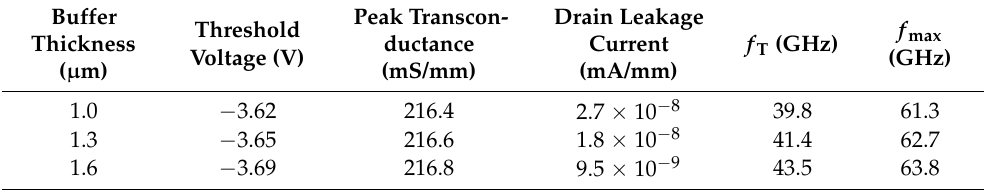
Table 2. DC and AC simulation results of the HEMT with different thicknesses of AlGaN buffer